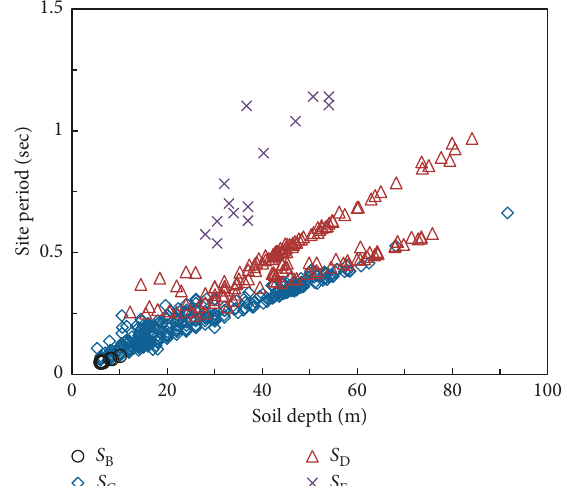
Figure 3: Site periods of 487 sites.